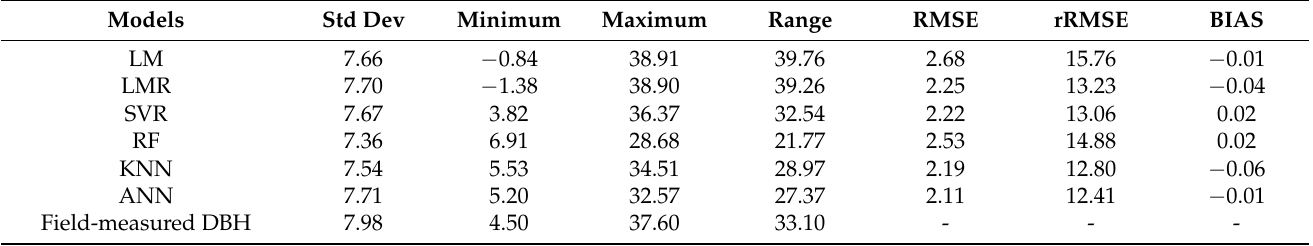
Table 6. Summary of statistical results of the predicted DBHs for the independent validation dataset calculated using six different methods.